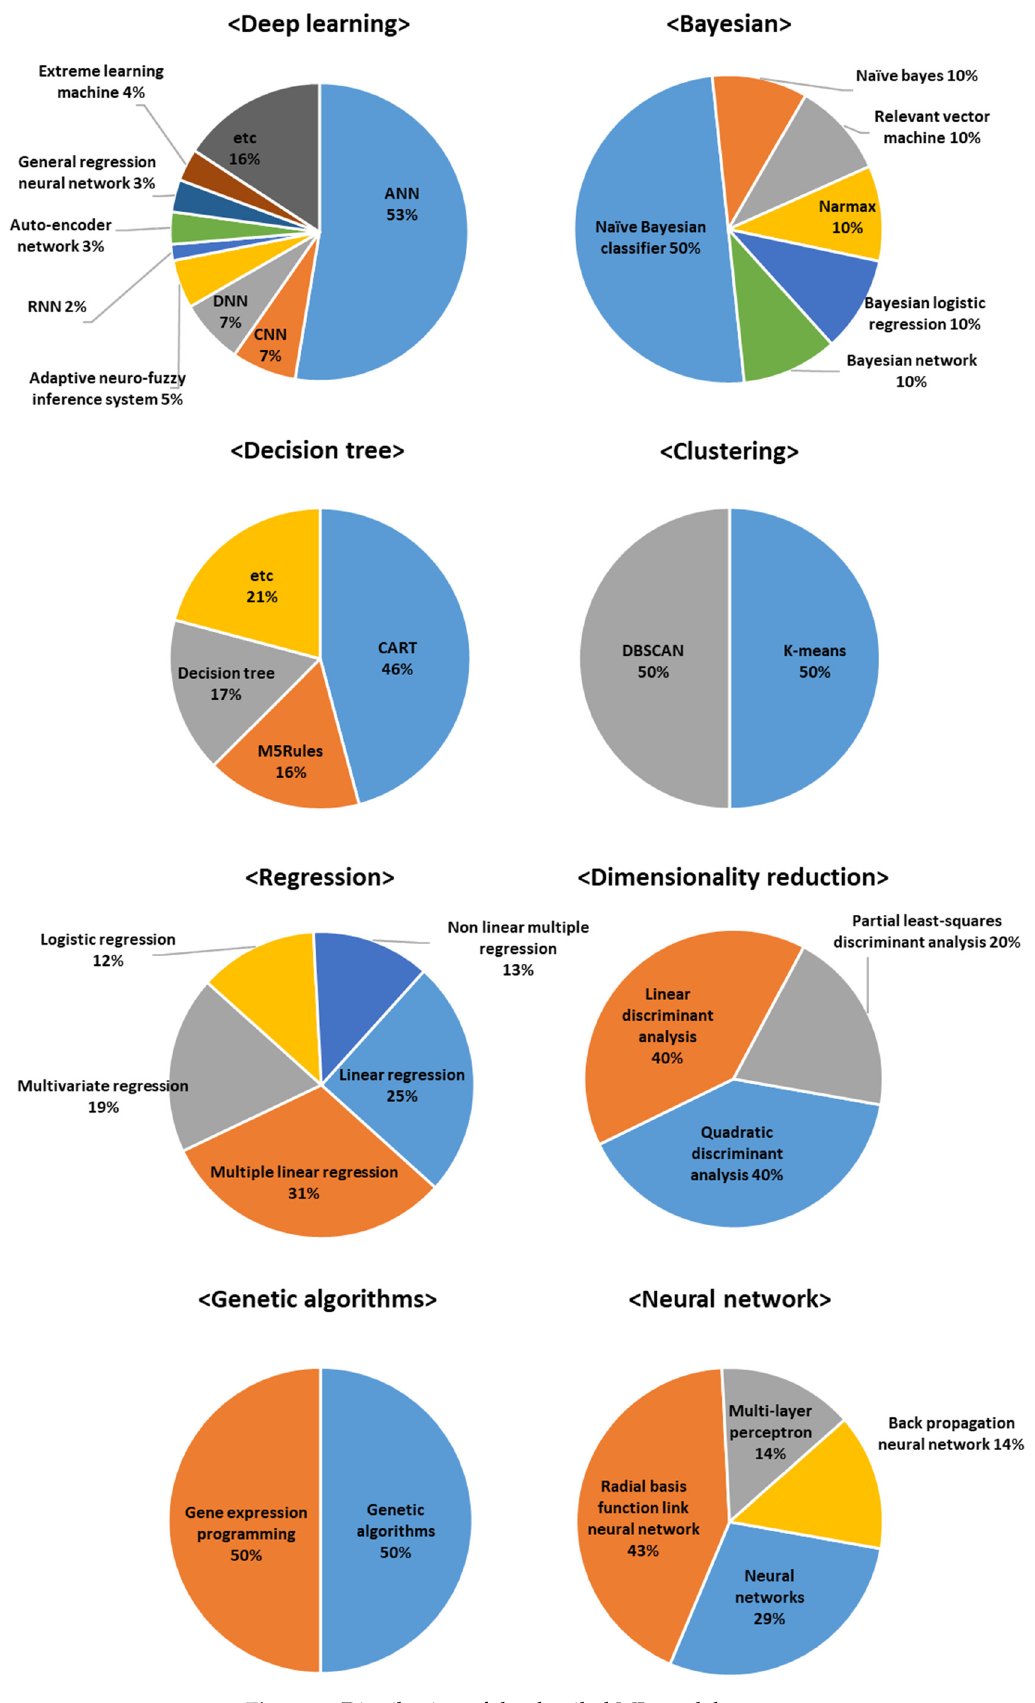
Figure 9. Distribution of the detailed ML model usage.